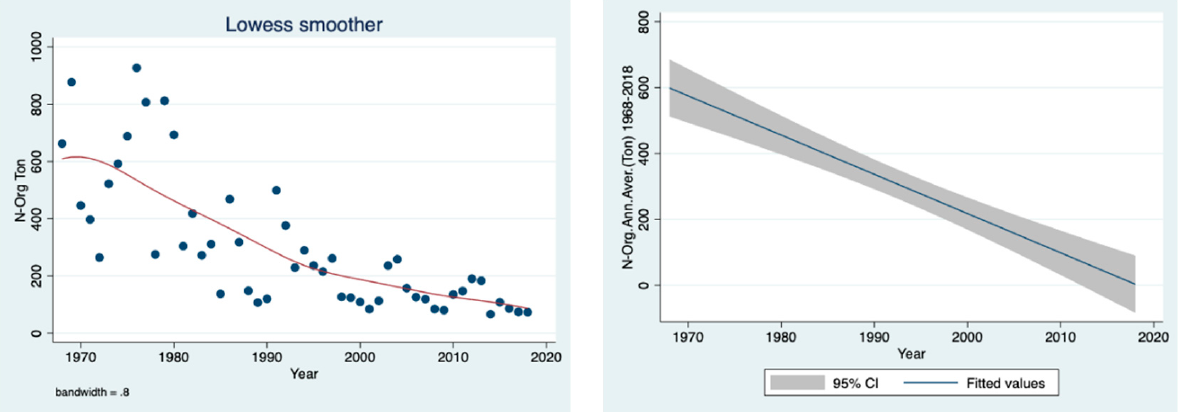
Figure 7. Linear prediction (95% CI) ( left ) and LOWESS smoother (0.8 bandwidth) trend of changes ( right ) between annual means of organic nitrogen loads (ton) in River Jordan waters (Huri Station) and years during 1968–2018.